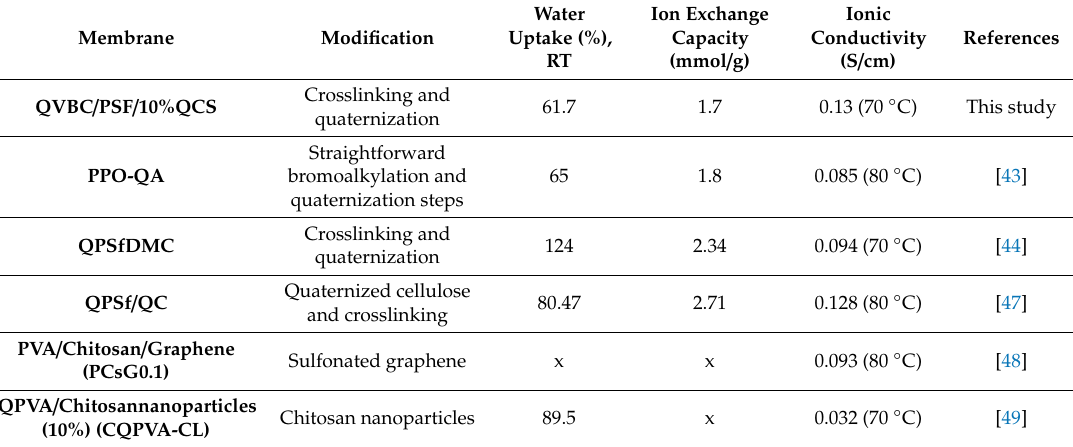
Table 2. Comparison of IC obtained via di ff erent